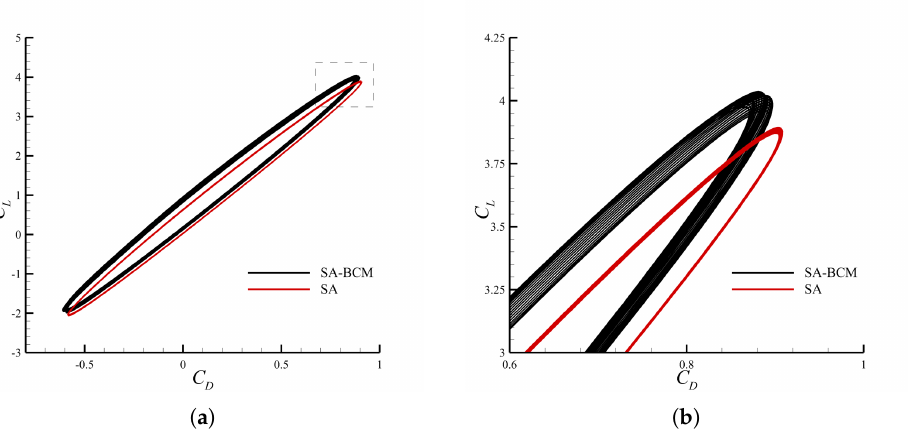
Figure 14. Time − dependent case. Instantaneous phase space representation of hydrodynamic forces over multiple motion cycles ( a ) and relative enlargement ( b ).